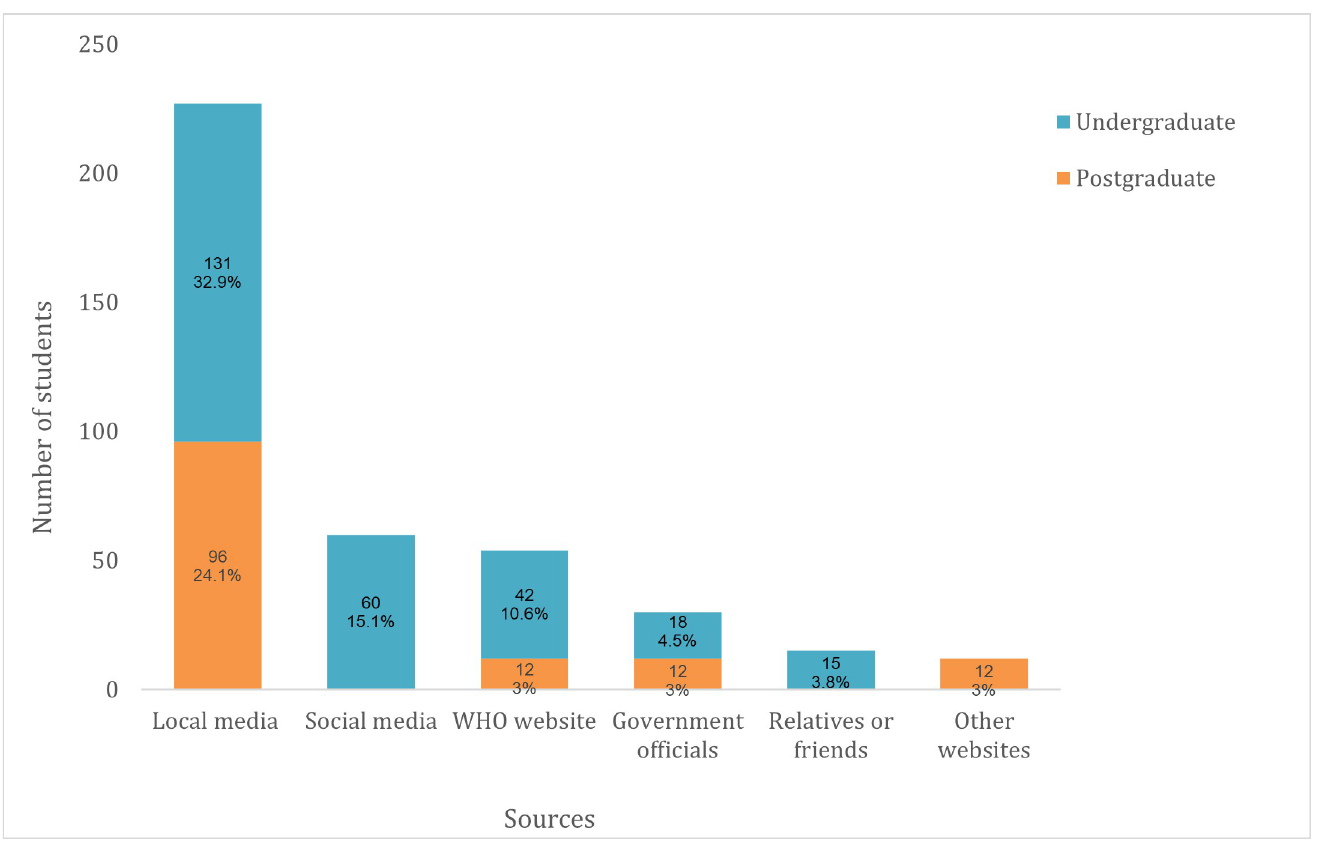
Fig 3. Sources of COVID-19 information.